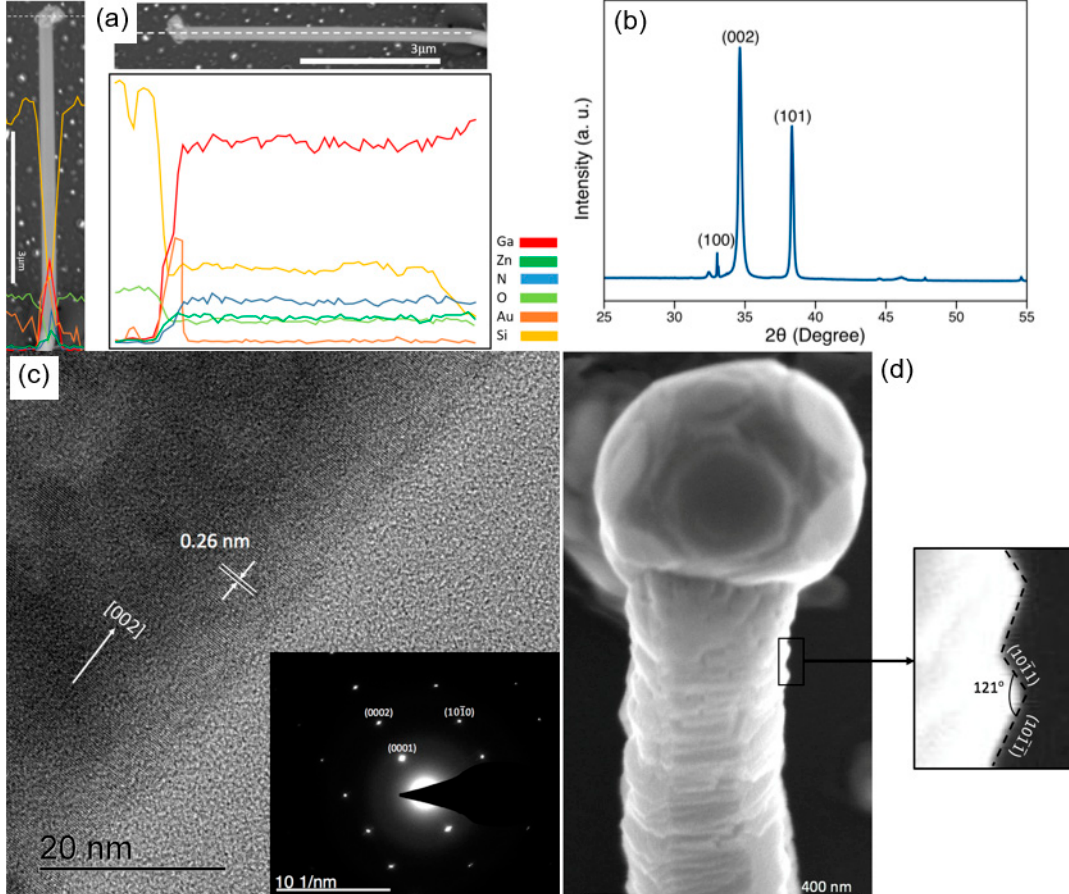
Figure 3. Chemical and structural characteristics of the synthesized nanowires. ( a ) Elemental profile of an individual nanowire along the tip cross-section and growth direction. ( b ) XRD pattern of the prepared thin film. ( c ) HRTEM images of an individual GaN:ZnO nanowire, showing the distance between two parallel crystal fringes and the favourable growth direction of the nanowires. Inset displays the SAED pattern of the nanowire. ( d ) High-resolution SEM image of an individual nanowire, showing the exposed (1011) and (1011) facets, determined from their position with respect to the [002] and the angle between the planes. The nanowires were prepared at T s = 1000 °C for 30 min at D = 8 cm downstream of the Ga 2 O 3 and ZnO source materials.